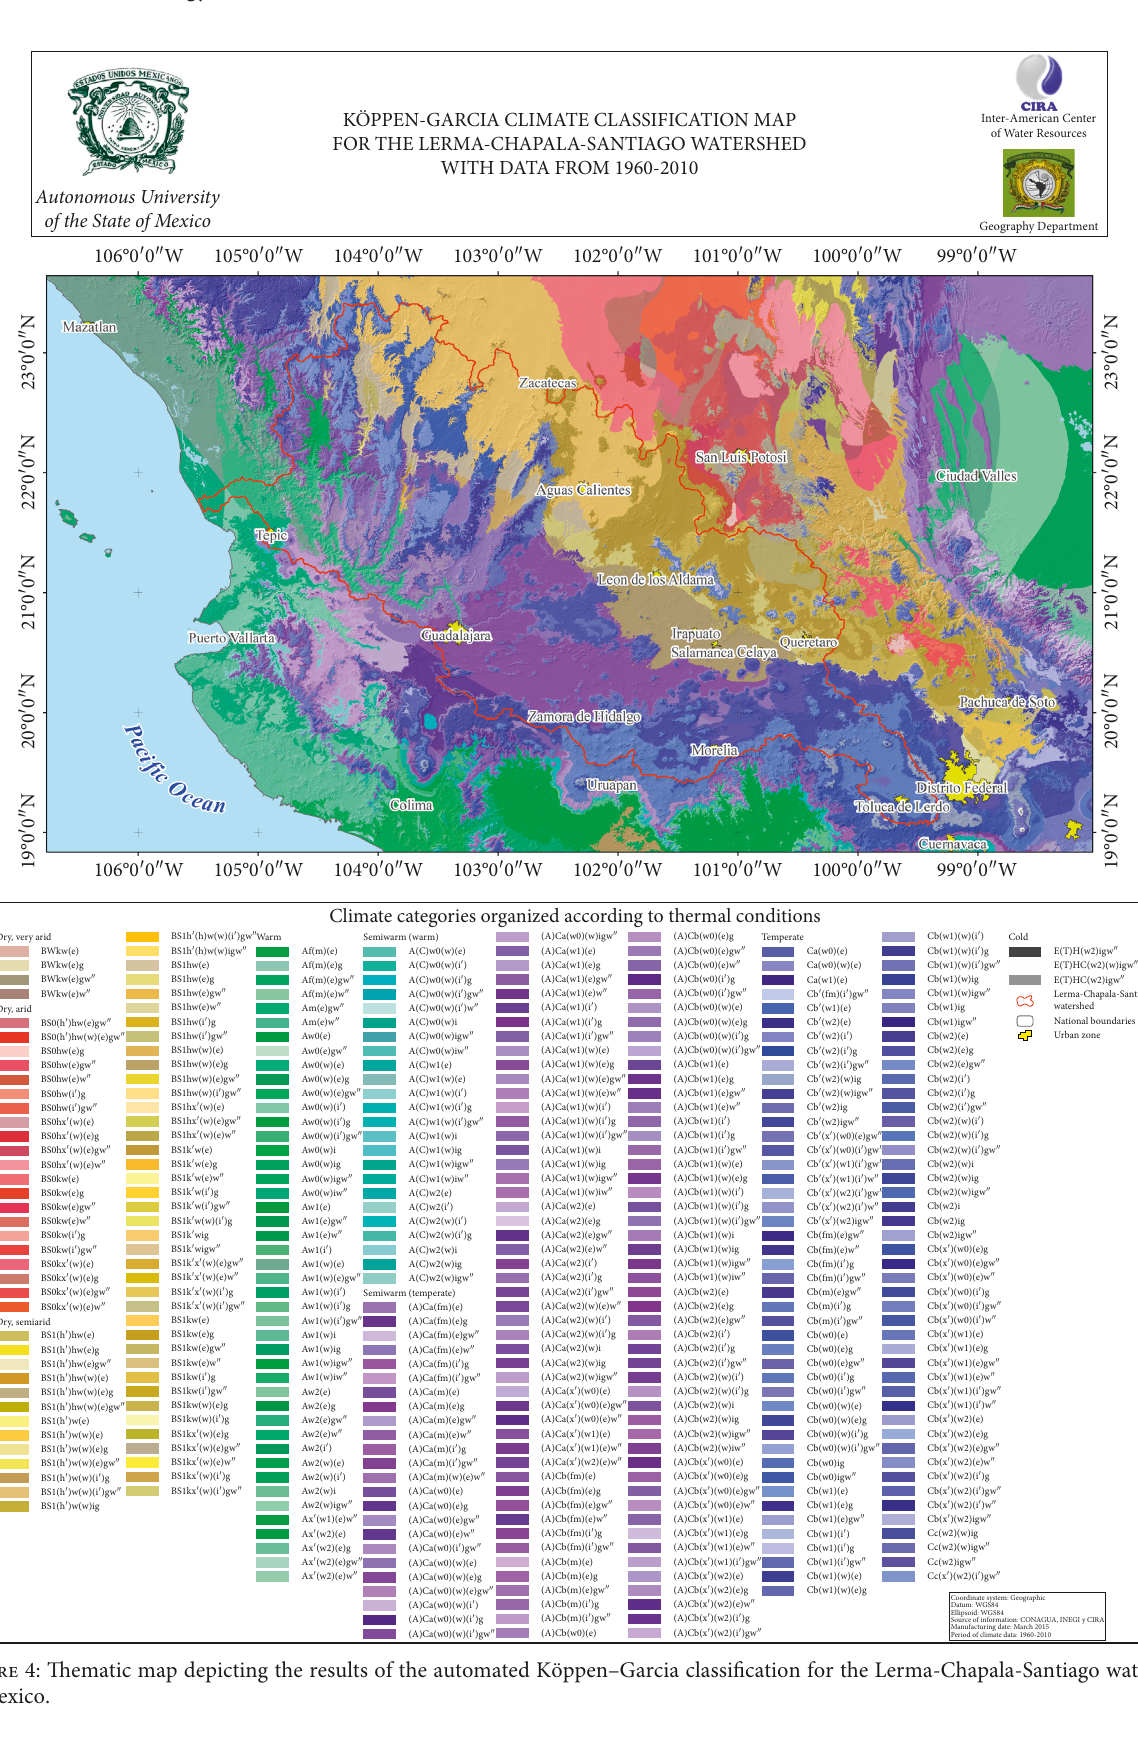
Figure 4: Thematic map depicting the results of the automated K¨oppen–Garcia classification for the Lerma-Chapala-Santiago watershed in